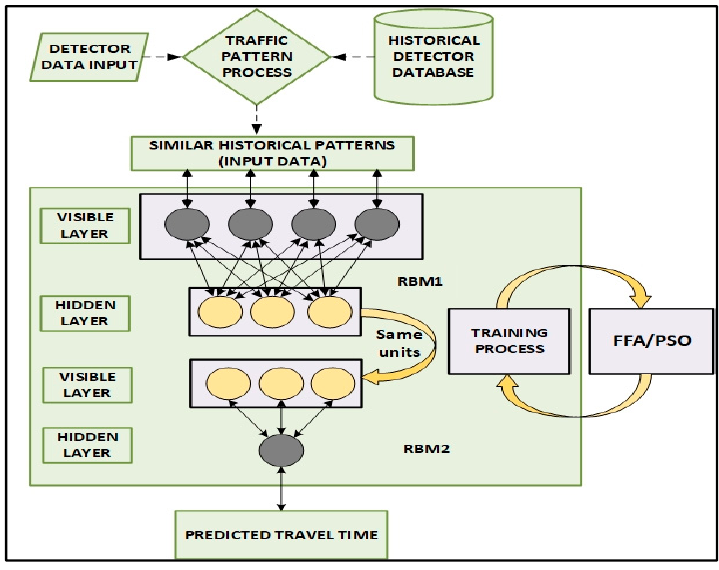
Figure 3. Steps of (DBN) with two (RBMs).